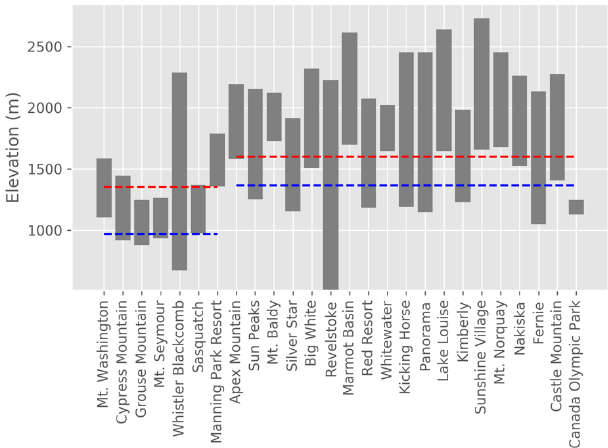
Figure 13. Elevation ranges (mean sea level – MSL) from ski resort bases to their mountain summits (retrieved from https:// www.onthesnow.com/canada/statistics.html) and average elevations of transition regions under CTRL and PGW simulations. Ski resorts are ordered from west to east. The dashed blue and dashed red lines represent the 4-month average transition region elevations under the CTRL and PGW simulations, respectively, in the west and east sub- areas that are separated at 121 ◦